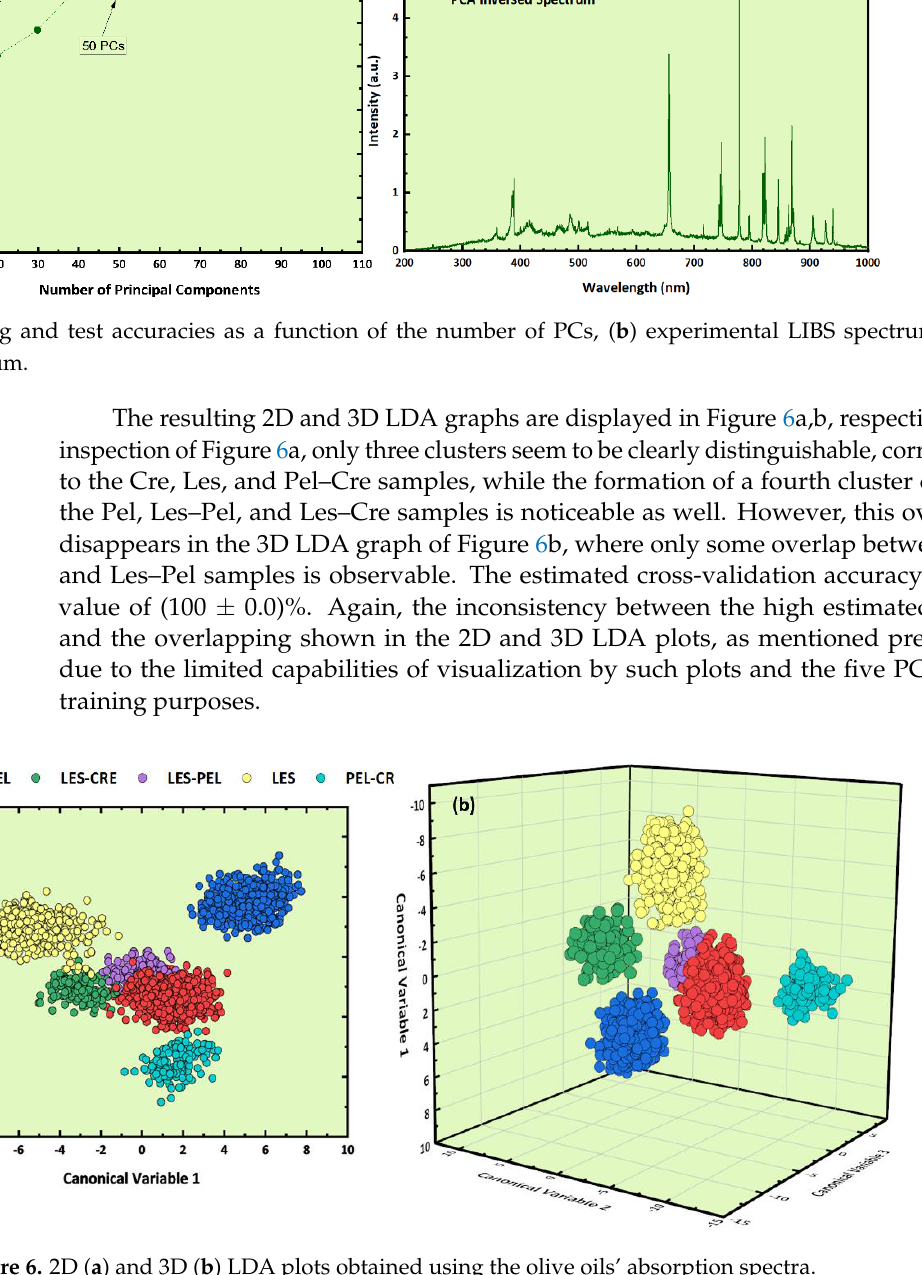
Figure 7. ( a ) Training and test accuracies as a function of the number of PCs, ( b ) experimental absorption spectrum and PCA-inversed spectrum.